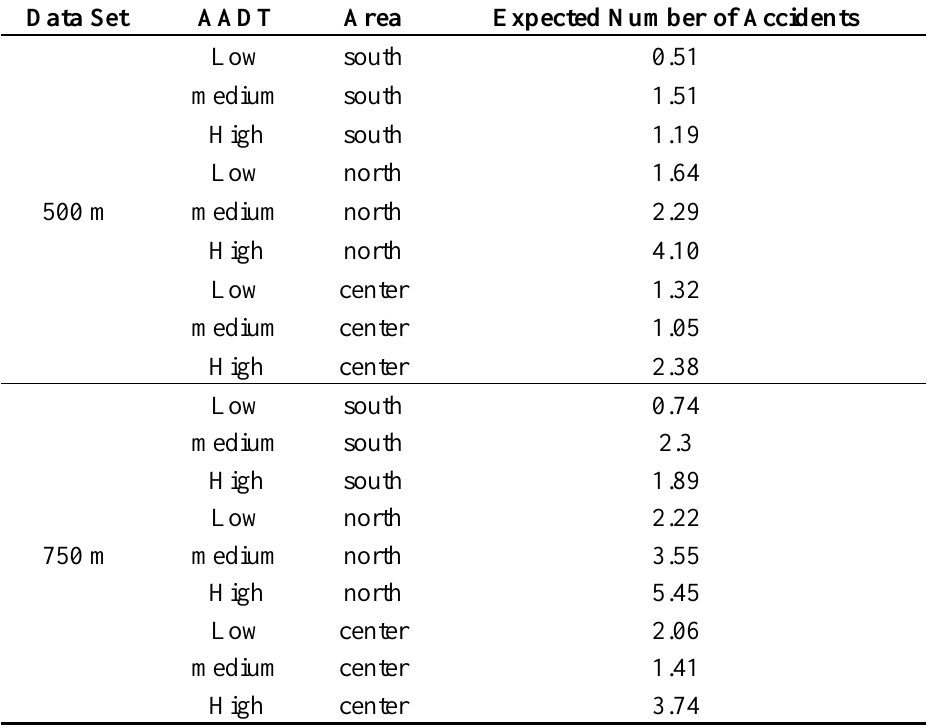
Table 7. Interactions—number of expected accidents divided into regions (Section lengths of 500 m and 750